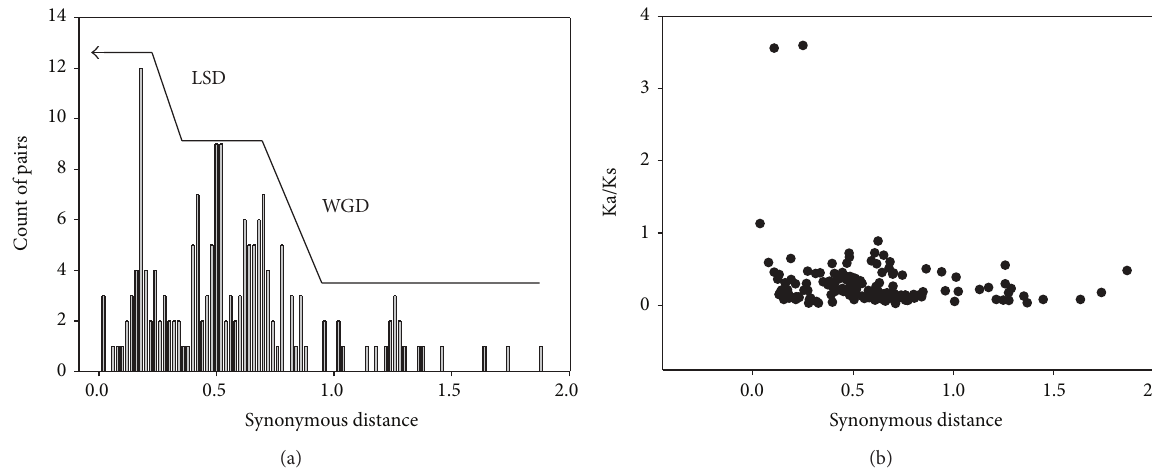
Figure 6: (a) Distribution of synonymous distance (Ks) between paralogous genes flanking duplicated CCCH IX genes in the three grass species. The histogram depicts the number of duplicate gene pairs ( 𝑦 -axis) versus synonymous distance between pairs ( 𝑥 -axis). CCCH IX blocks experienced whole-genome duplication (WGD) in the first stage of their evolution and large-scale duplication (LSD) in the second stage. (b) Ka/Ks ratios of duplicated CCCH IX genes and their flanking paralogs in the three grasses. The 𝑦 - and 𝑥 -axes denote the Ka/Ks ratio and synonymous distance for each pair,